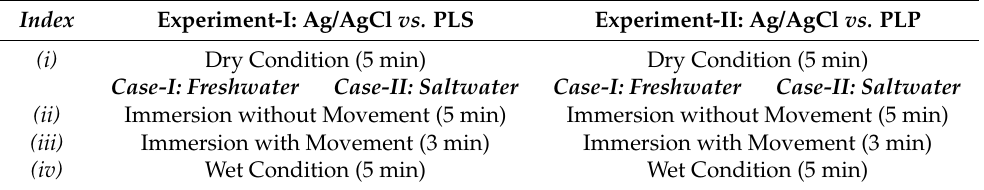
Table 1. Experimental